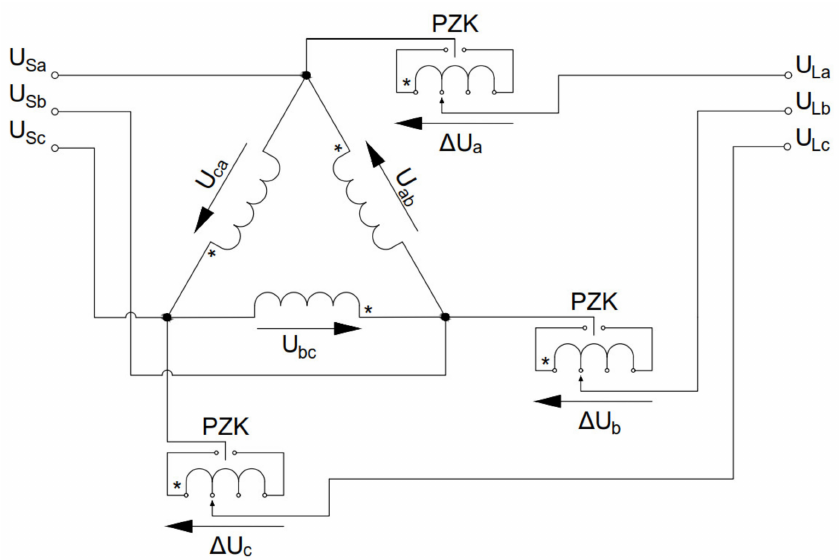
Figure 2. A connection scheme of the asymmetrical direct